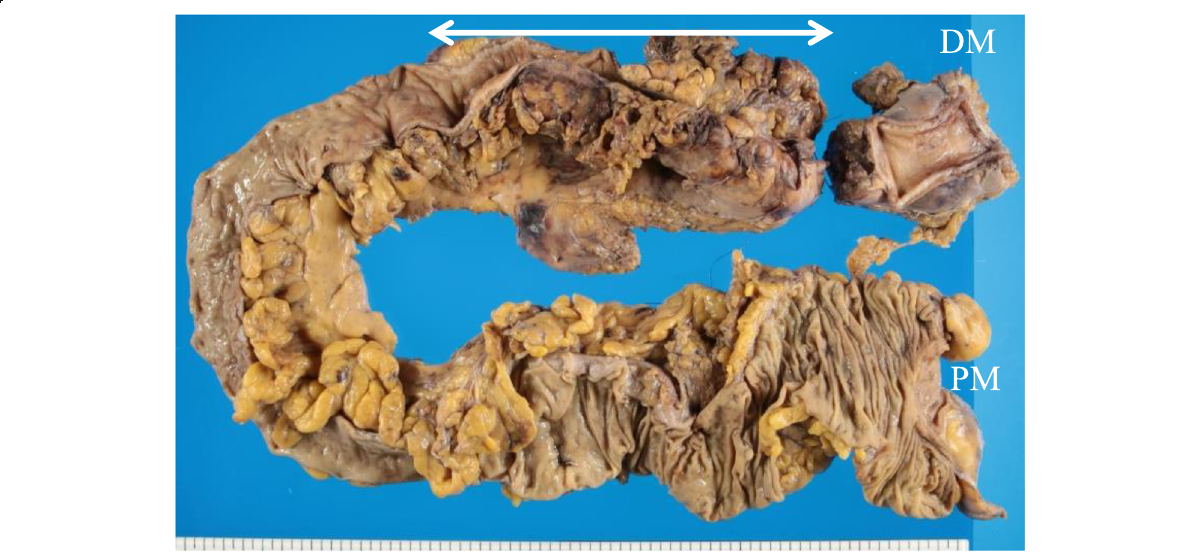
Fig. 9 Resected specimen showing severe stenosis from the descending colon to the sigmoid colon (white arrow)